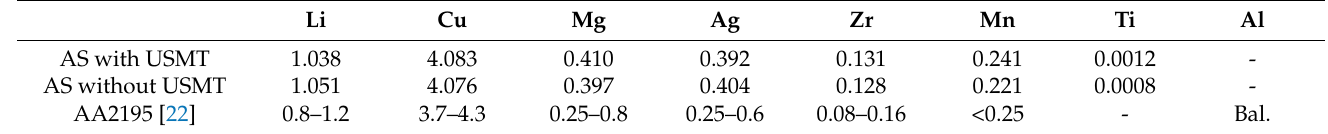
Table 1. Components of 2195 aluminum–lithium alloy (mass fraction/%)